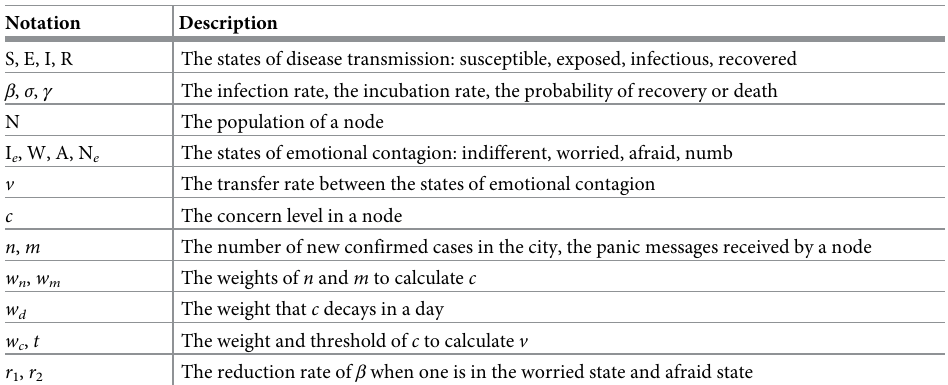
Table 1. Description of the notations used in our